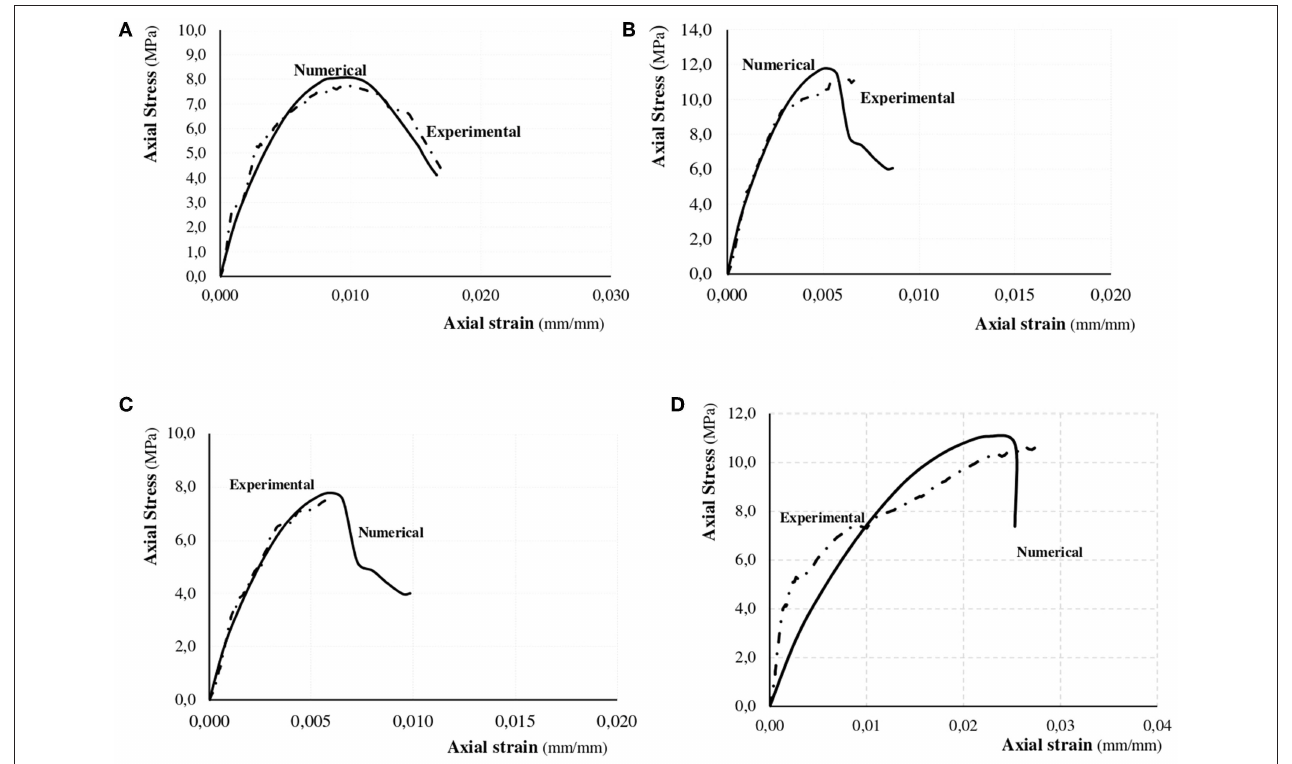
Confined Specimen Figure 12 shows the comparison between the numerical/experimental curves for masonry columns confined